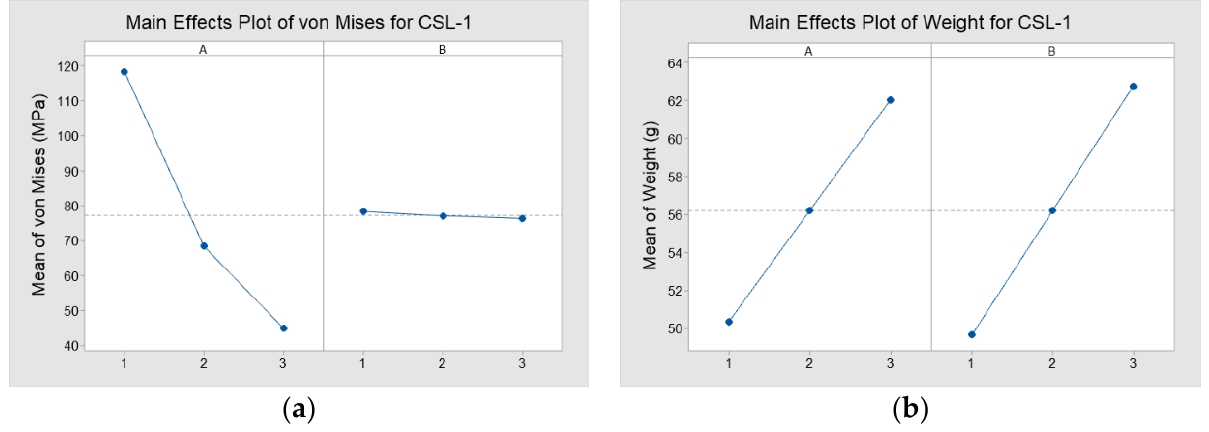
Figure 15. Study of the effect of the thickness of the first and second regions for the CSL-1 structure.